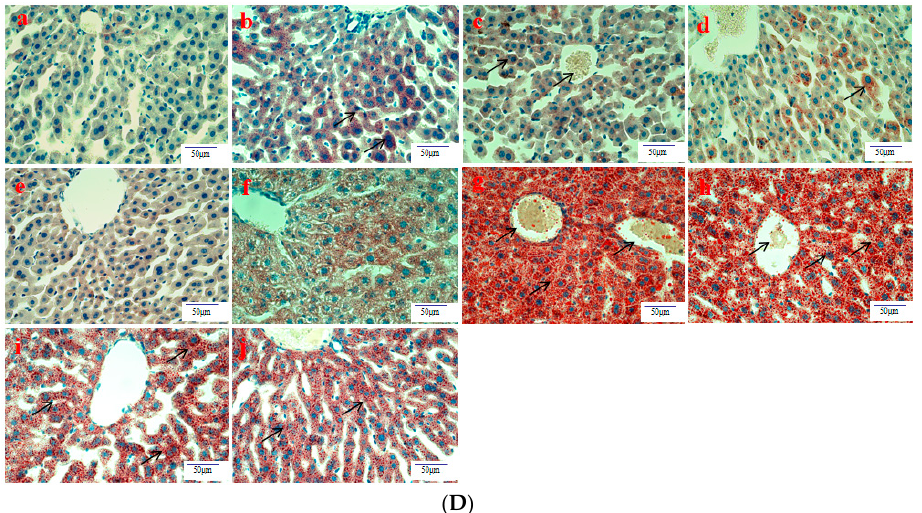
Figure 2. The histopathological observation of BBE on subacute and acute alcohol-induced liver damage (liver appearance, ( A ); analysis of BBE with H&E staining (( B ), ×400), Sirius red staining (( C ), ×400), and oil red O staining (( D ), ×400) (( a ), subacute control group; ( b ), subacute model group; ( c ), subacute low-dose BBE group; ( d ), subacute medium-dose BBE group; ( e ), subacute high-dose BBE group; ( f ), acute control group; ( g ), acute model group; ( h ), acute low-dose BBE group; ( i ), acute medium-dose BBE group; ( j ), acute high-dose BBE group).